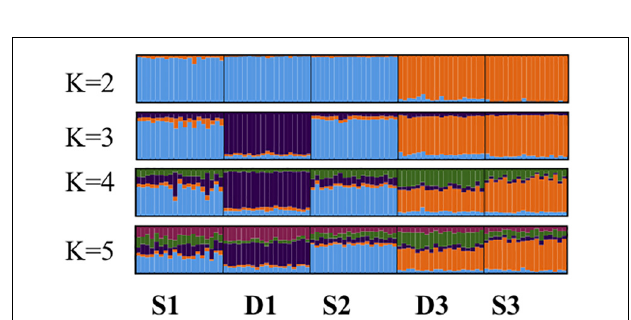
FIGURE 4 | STRUCTURE analyses of five populations of Fucus vesiculosus from the Öresund strait. K = 2 is the most likely number of clusters. S indicates populations from the Swedish side of the strait and D indicates populations from the Danish side. The subscripts 1–3 indicate populations from north to south (see Figure 1